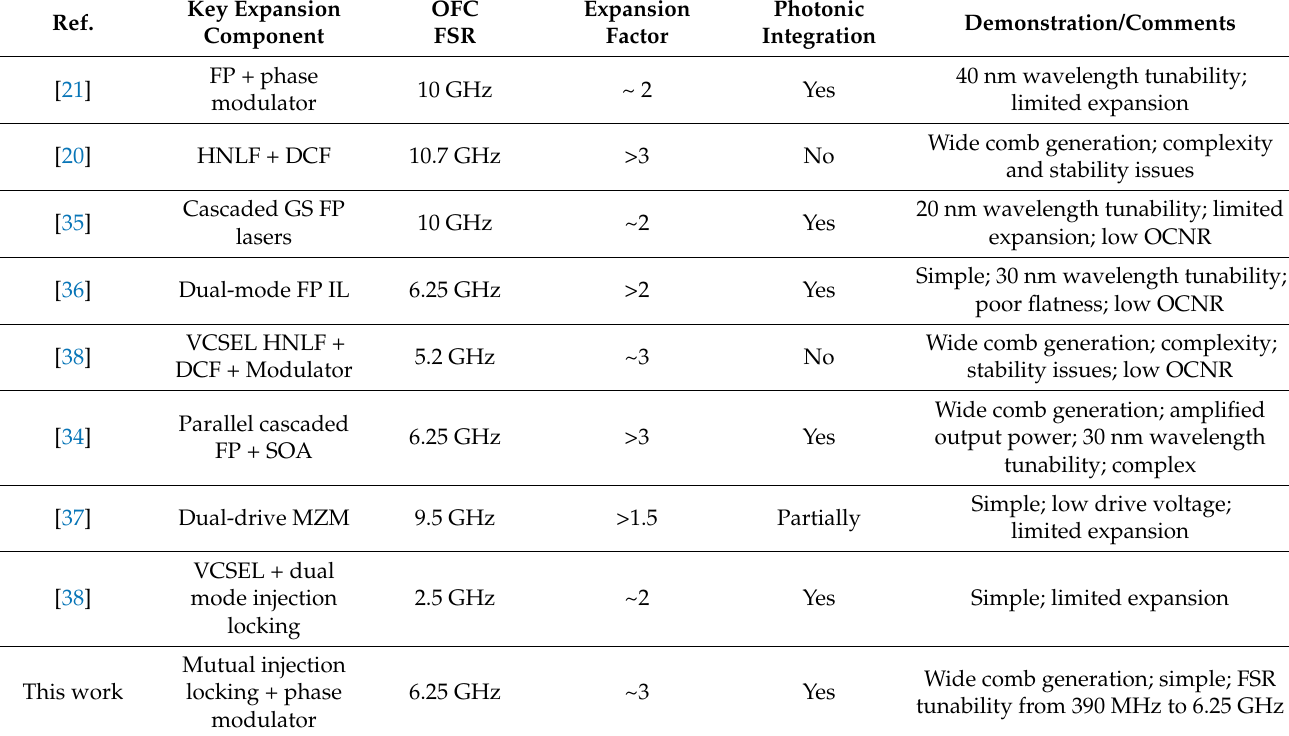
Table 1. Survey summary of GSL expansion